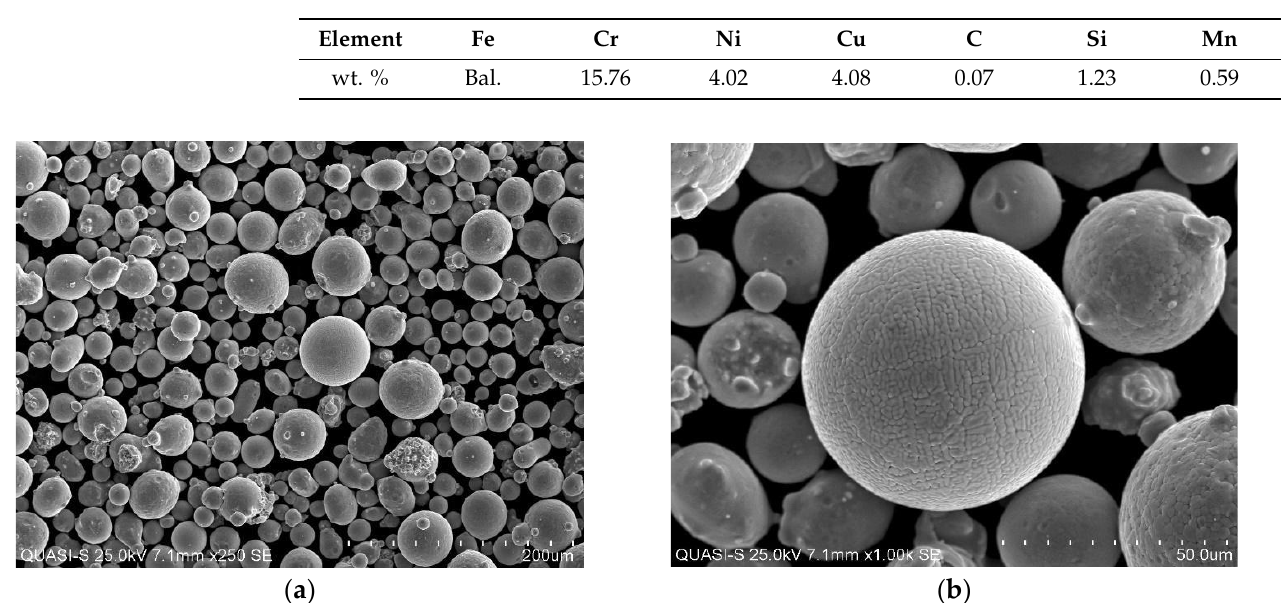
Figure 3. Powder morphology reveal by SEM observation at ( a ) 250 and ( b ) 1000 magnification scale.